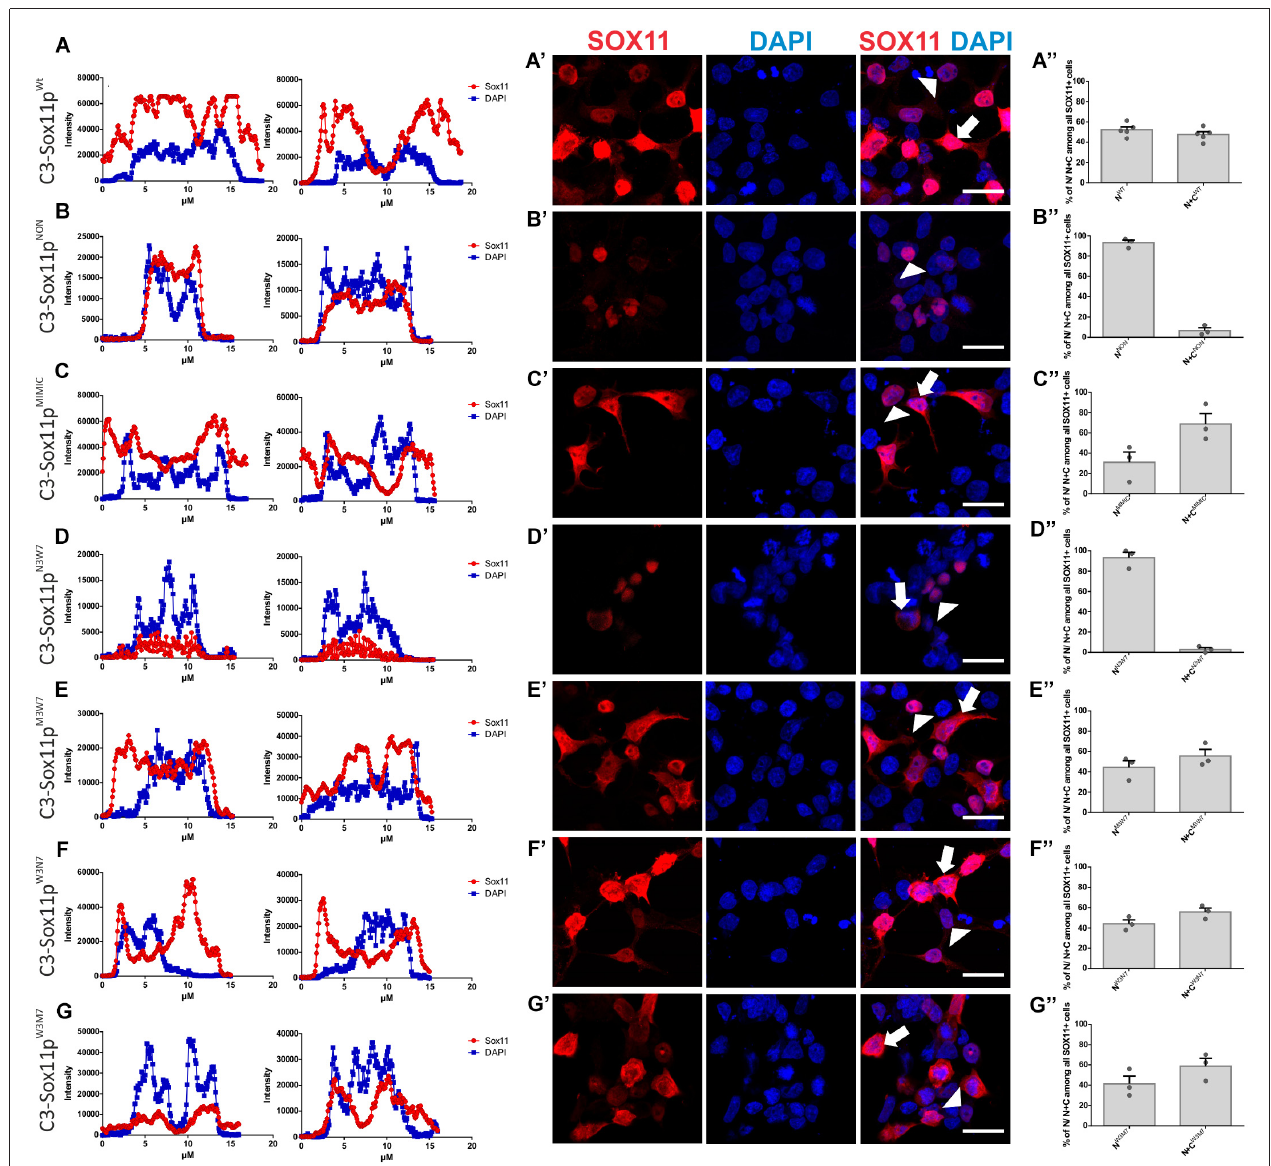
FIGURE 5 | SOX11’s non-phosphorylatable form leads to nuclear localization. (A–G) Representative line intensity plots of HEK293T cells transfected with SOX11 wildtype (WT) and mutants. The blue line represents DAPI intensity, the red line represents SOX11 intensity. (A (cid:48) –G (cid:48) ) Immunostaining for SOX11 (red) and DAPI (blue) of cells transfected with SOX11 WT and mutants were to determine the subcellular localization of SOX11 phospho-mutants. Note that the C3-Sox11p NON (B (cid:48) ) and C3-Sox11p N3W7 (D (cid:48) ) are almost exclusively localized in the nucleus. Arrow: cell with nuclear and cytoplasmic localization of SOX11. Arrow head: cell with only nuclear localization of SOX11. Scale bars: 20 µ m. (A (cid:48)(cid:48) –G (cid:48)(cid:48) ) Percentage of cells with nuclear localization (N) or nuclear and cytoplasmic (N + C) localization of the different SOX11